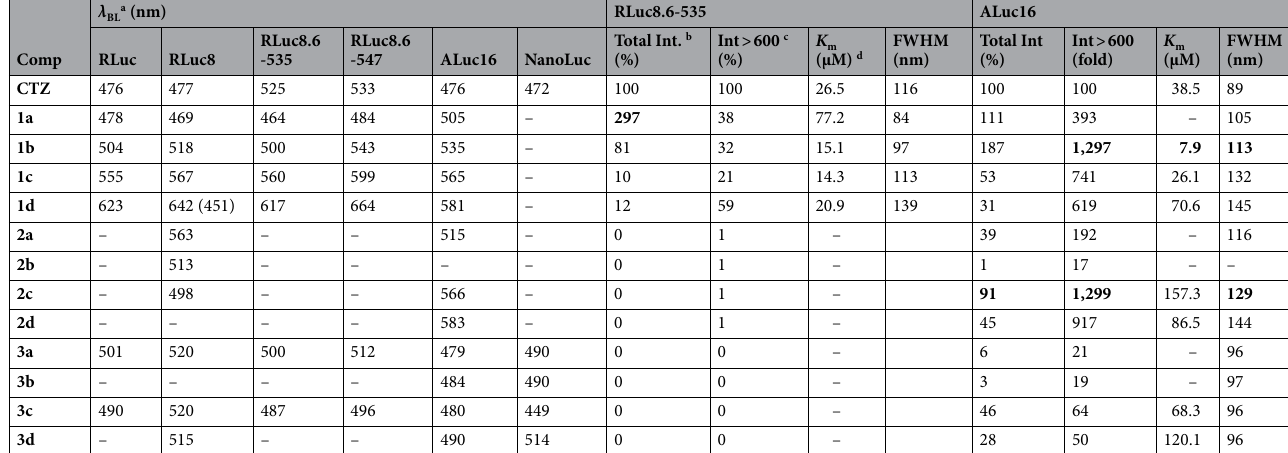
Table 1. BL properties of CTZ analogues with various marine luciferases. The table summarizes BL maximum wavelengths ( λ BL ), the total BL intensities (Total Int.), the intensity ratios exceeding 600 nm over the total intensities (Int > 600), Michaelis constants ( K m ), and full width half maximum (FWHM). Abbreviations: CTZ, native coelenterazine; RLuc, Renilla luciferase; RLuc8, Renilla luciferase 8; RLuc8.6–535, Renilla luciferase 8.6– 535; ALuc16, Artificial luciferase 16. a BL maximum wavelength. b The whole BL intensities of CTZ analogues, compared to that of CTZ. c The ratios of the BL intensities that is longer than 600 nm in the wavelength. d The Michaelis–Menten